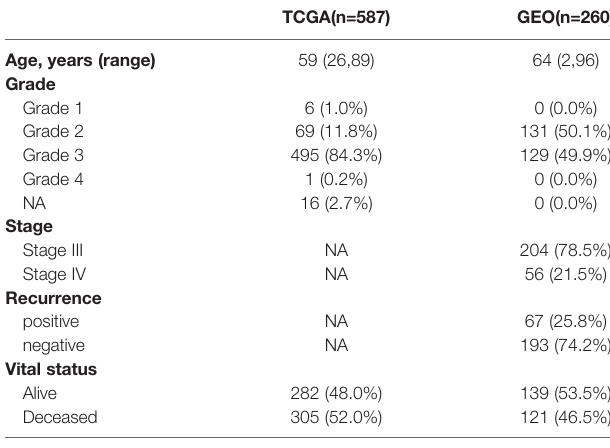
TABLE 1 | Clinical characteristics of the samples in TCGA and GEO